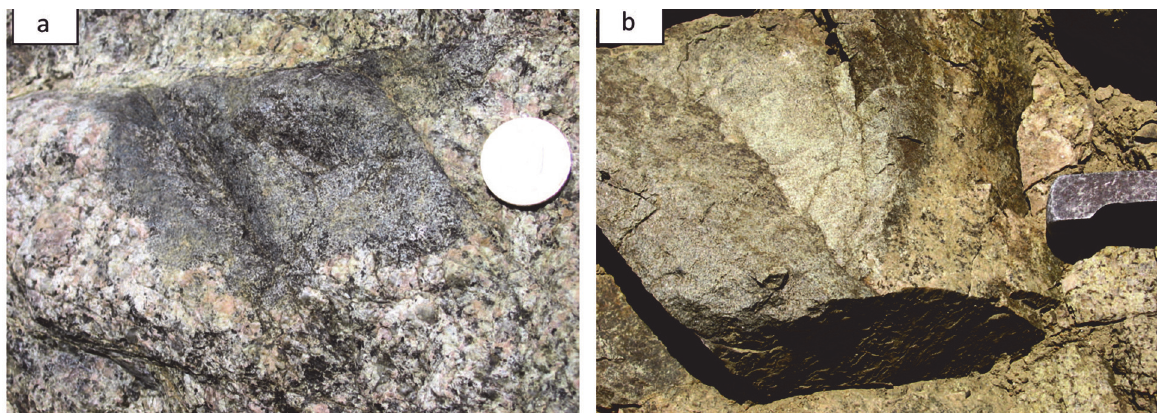
Fig. 3. Field photographs of MMEs displaying sharp (a) and cuspate (b) contacts with granodiorite (a) and granite